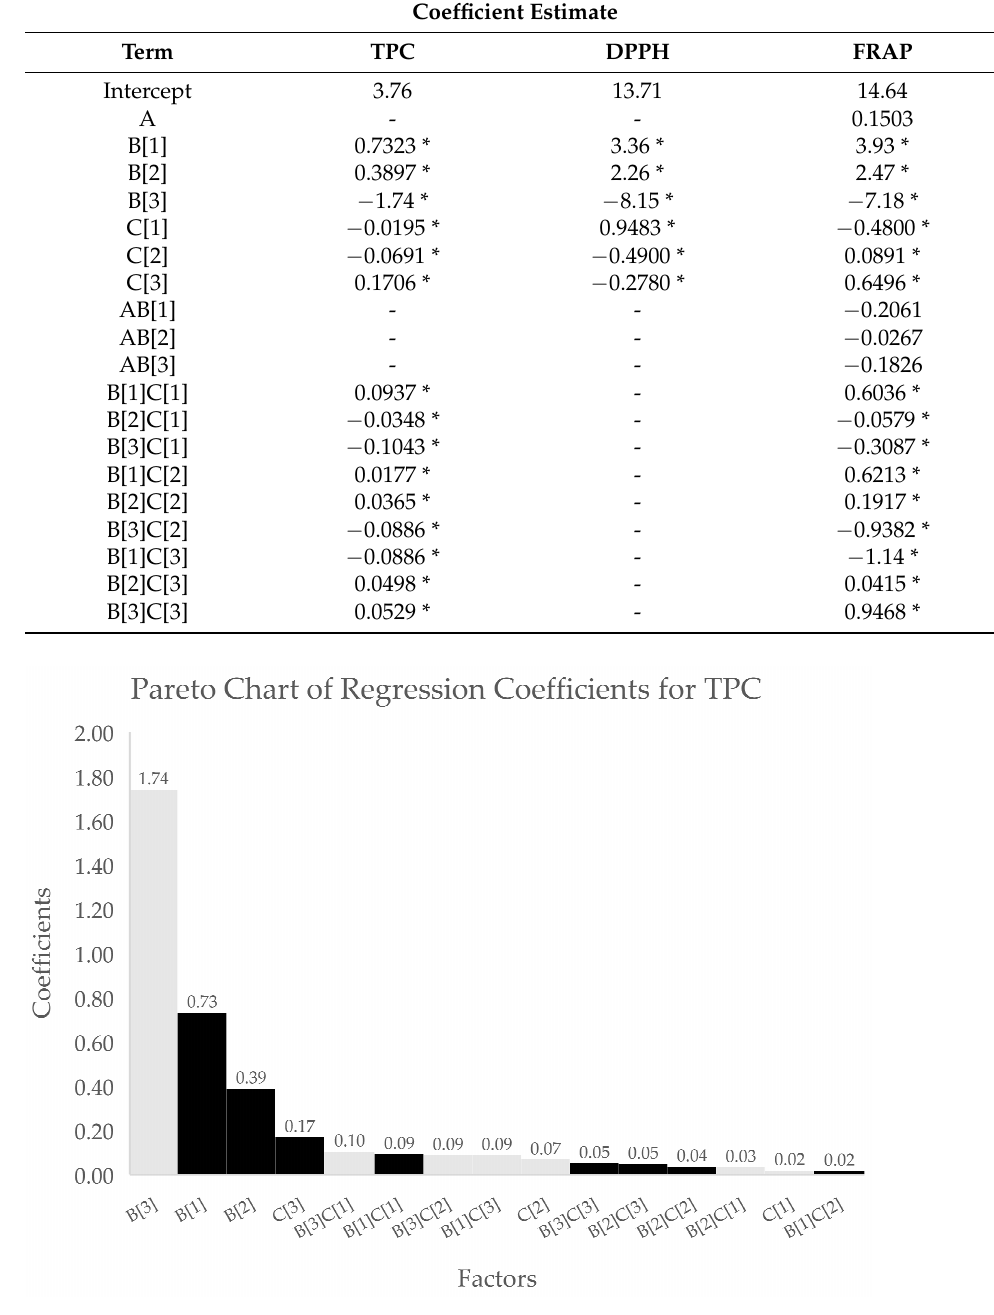
Figure 1. Pareto chart of regression coefficients for TPC assay data. X-axis indicates the different factors (B[ n ] = solvent type, C[ n ] = extraction process, and B[ n ]C[ n ] = interaction of solvent type and extraction process) while the values in the left y-axis indicate the coefficient values for the corresponding factors. Black bars indicate positive effect, while white bars indicate negative effect on TPC.